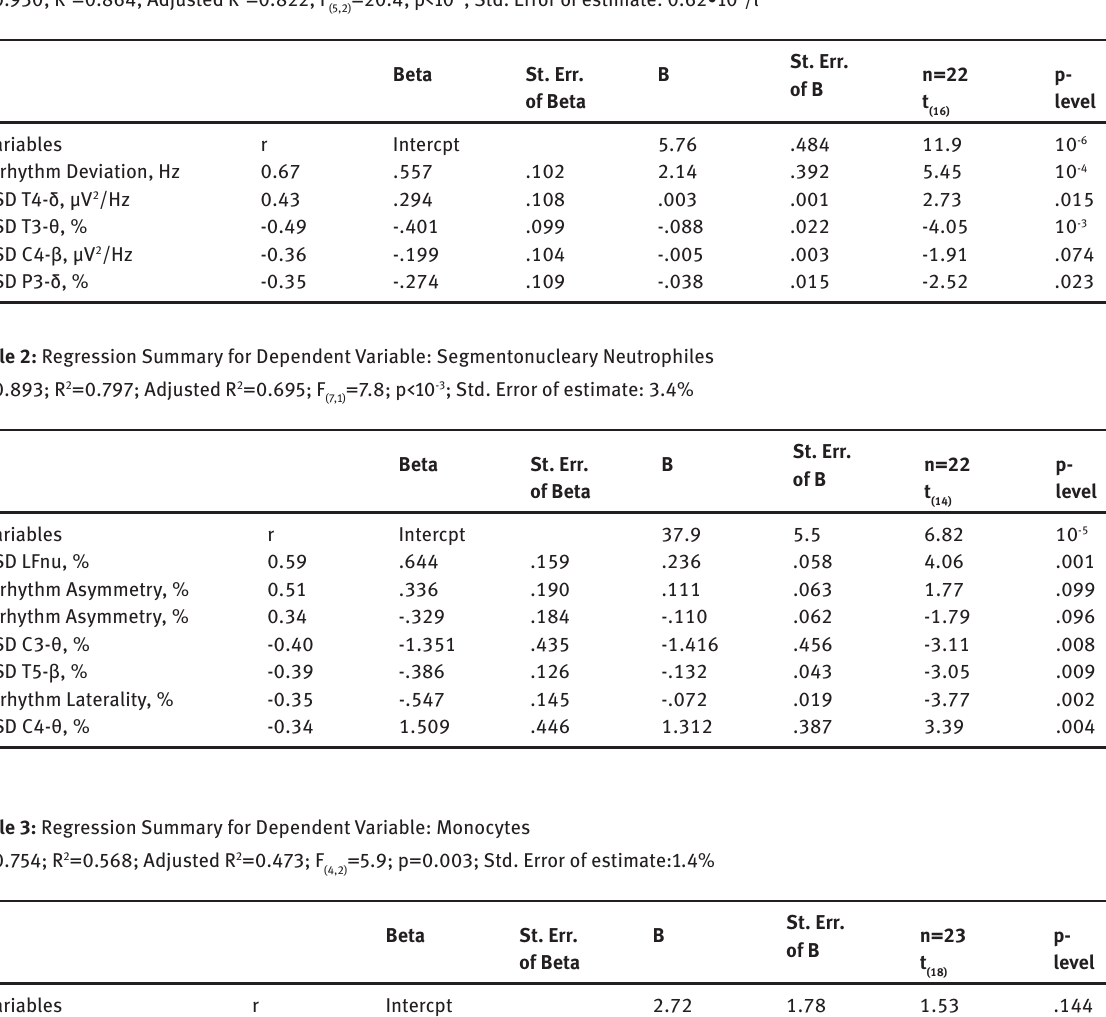
Table 1: Regression Summary for Dependent Variable: Leukocytes